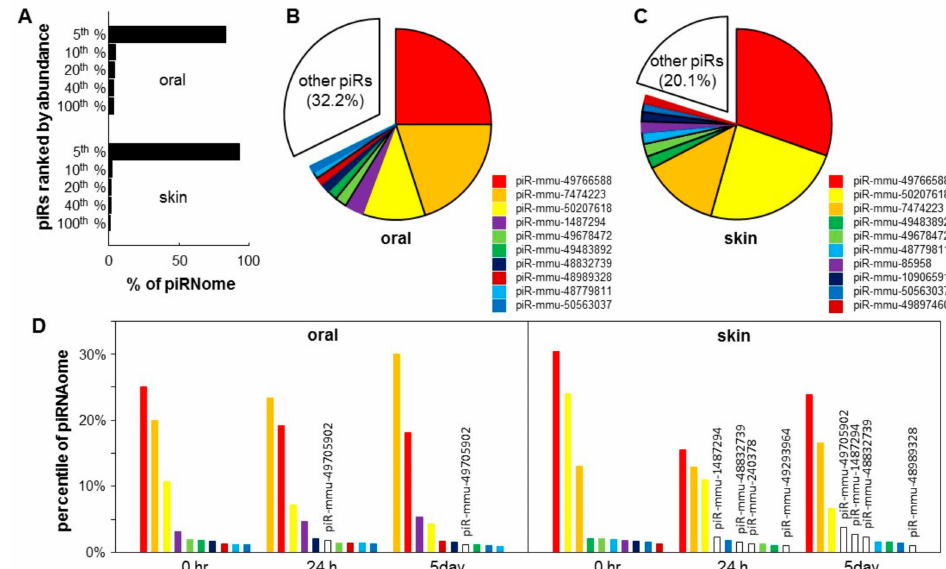
Figure 2. Piwi-interacting RNA (piRNA) landscape of skin and oral mucosa. Baseline piRNA profiles were obtained on the normal mouse skin and oral mucosa (hard palate) ( n = 3 for both groups). ( A ) The piRNA landscape is presented as histograms of the percentage of total piRNA contents (piRNAome) vs. piRNA species grouped by their abundance (top 5%, 6–10%, 11–20%, 21–40%, and 41–100%). Pie charts illustrated that the top 10 most abundant piRNAs account for 67.8% and 79.9% of the piRNAome in the oral mucosa (palate) ( B ) and skin ( C ). ( D ) Injury induced changes in the levels of the top 10 most abundant piRNAs in the skin and oral mucosa during the wound healing time course (0 h, 24 h and 5 days), expressed as a percentage of the